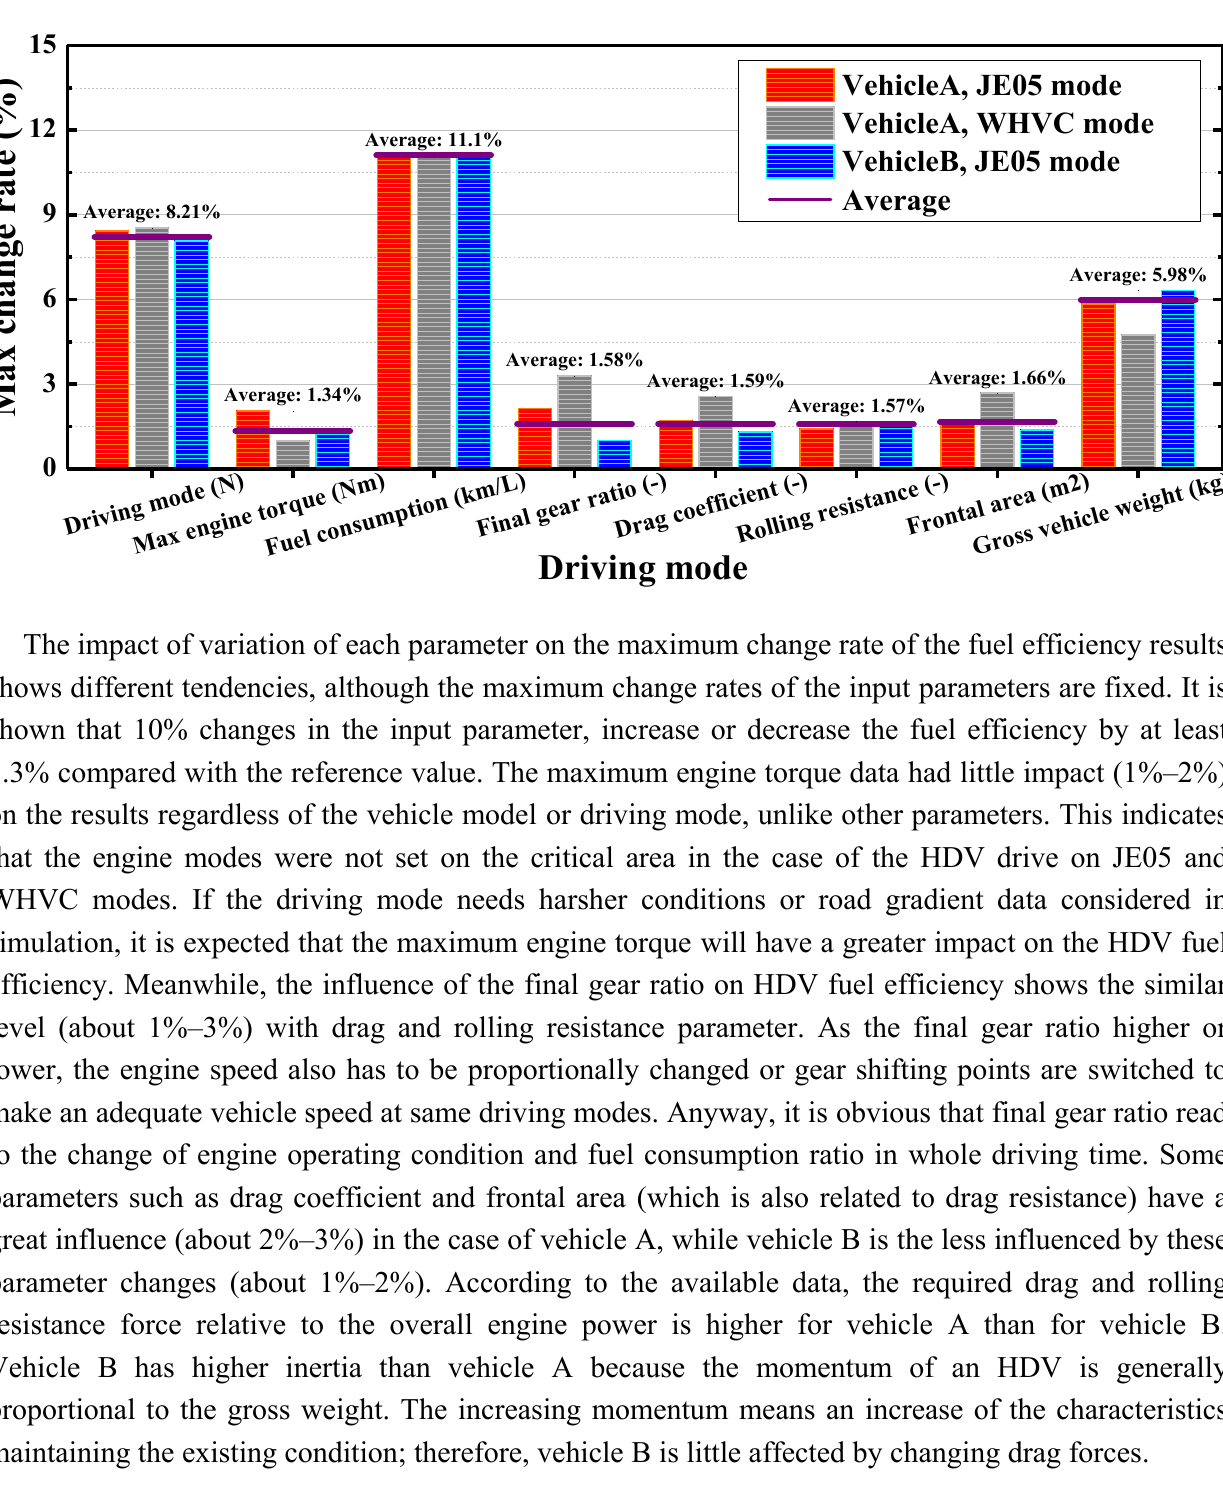
Figure 13. Maximum change rate of the predicted fuel efficiency according to input parameter